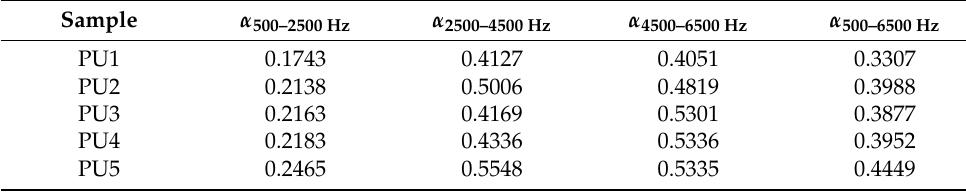
Table 3. Normalized absorption coefficient at different frequency